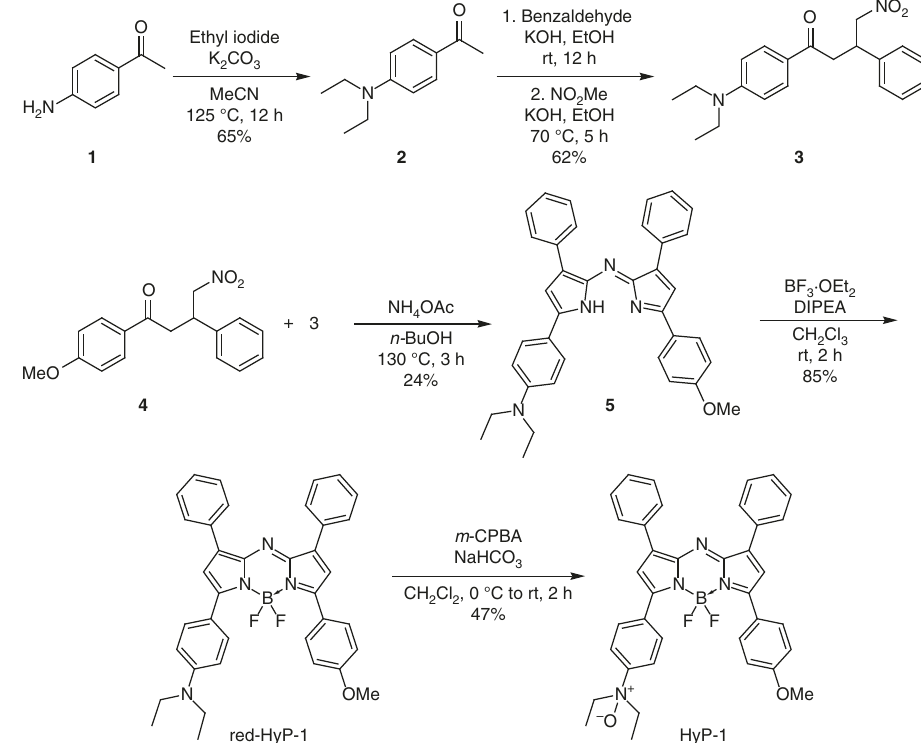
Fig. 2 Synthesis of HyP-1 and red-HyP-1. Red-HyP-1 was obtained via heterodimerization of key precursors 3 and 4 , followed by BF 2 incorporation using BF 3 · OEt 2 . HyP-1 was obtained via oxidation of red-HyP-1 using m